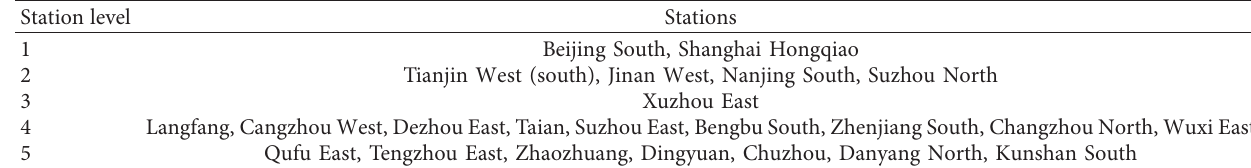
Table 4: Updated station